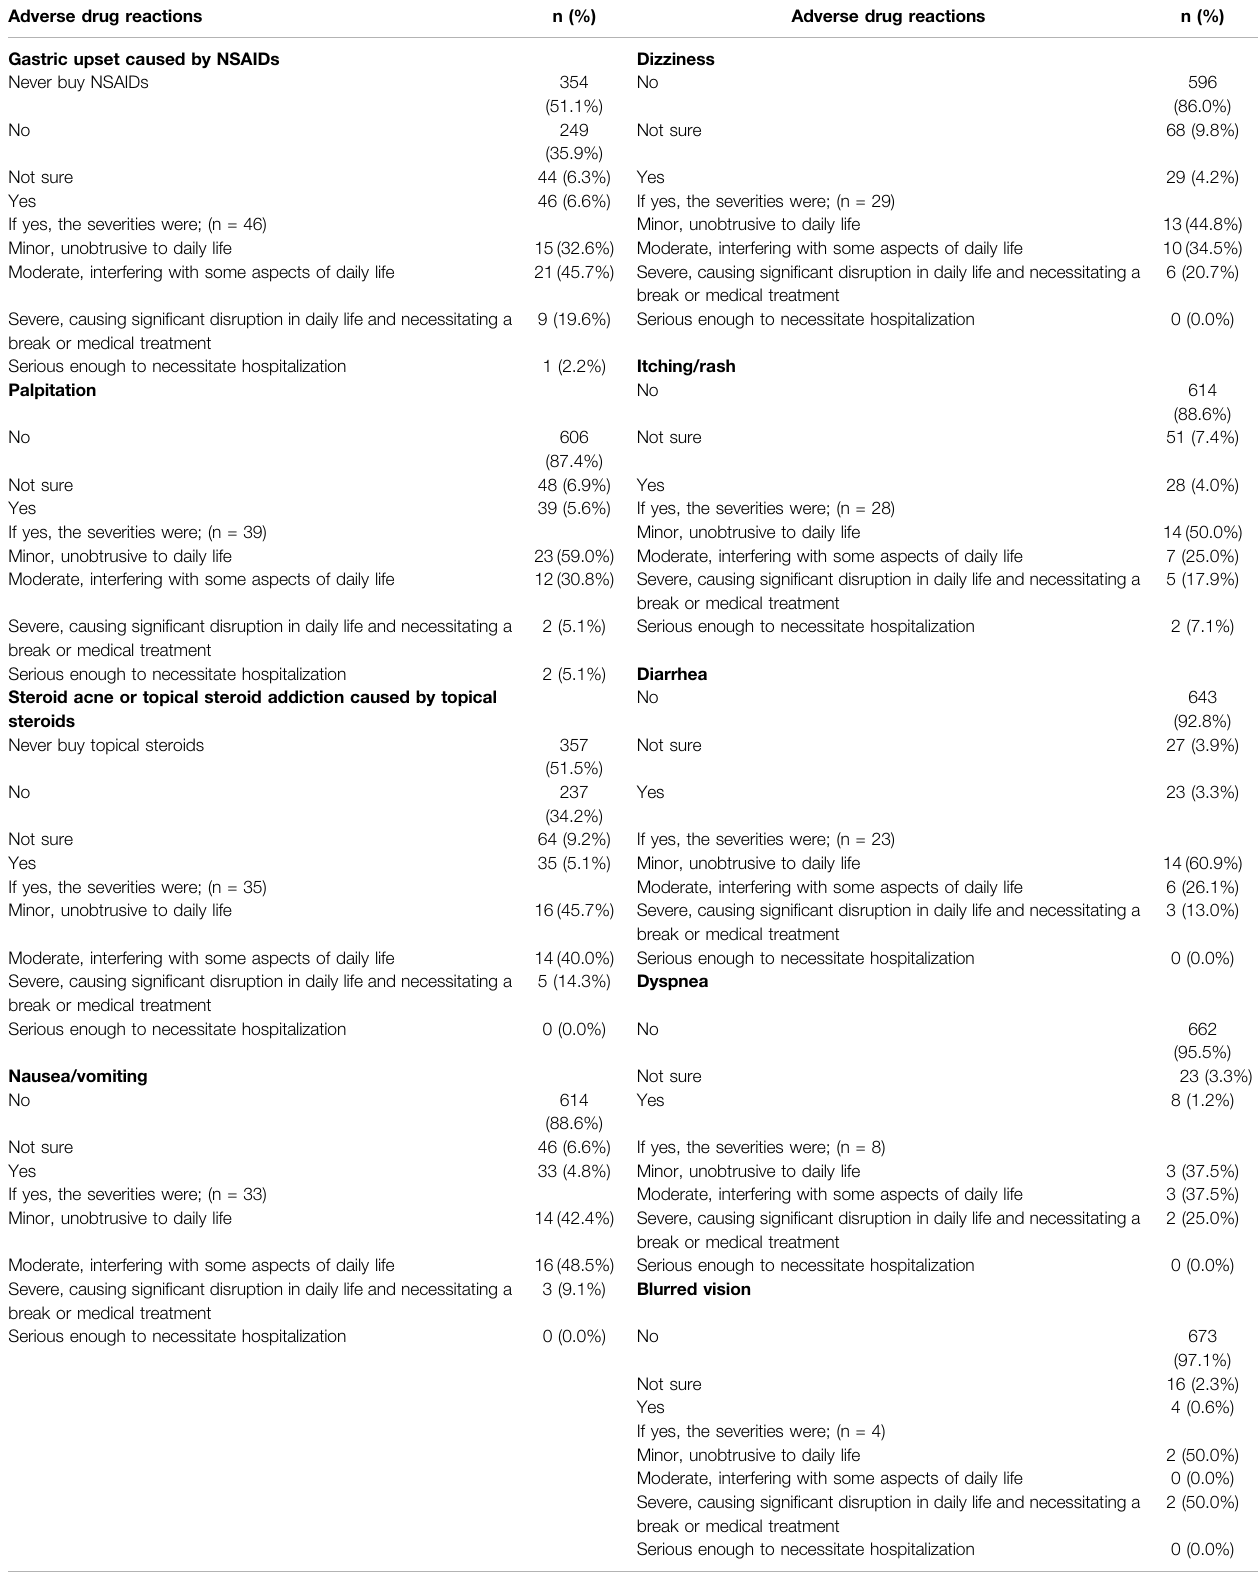
TABLE 3 | Adverse drug reactions ( n (cid:1) 693). Adverse drug